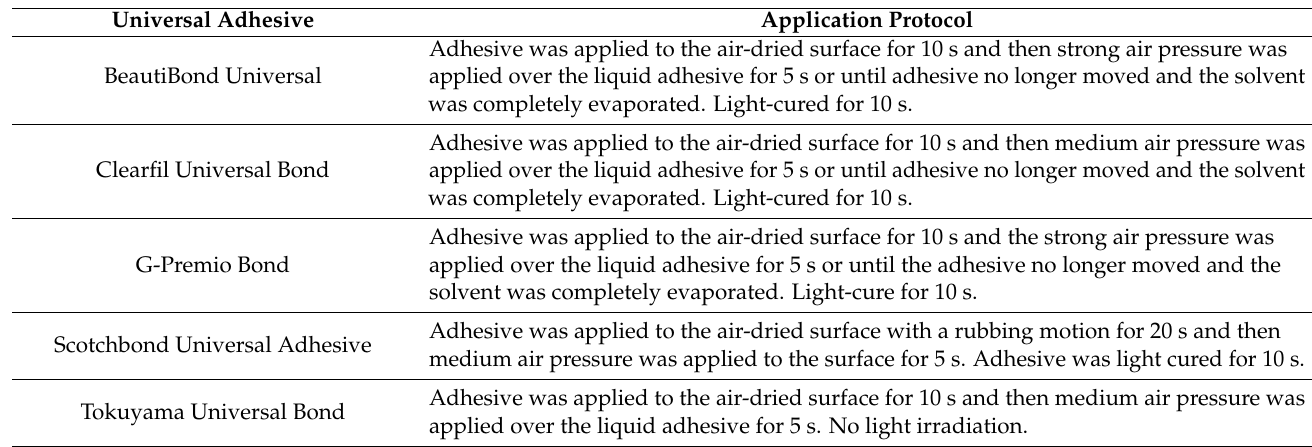
Table 3. Application Protocols for Tested Universal